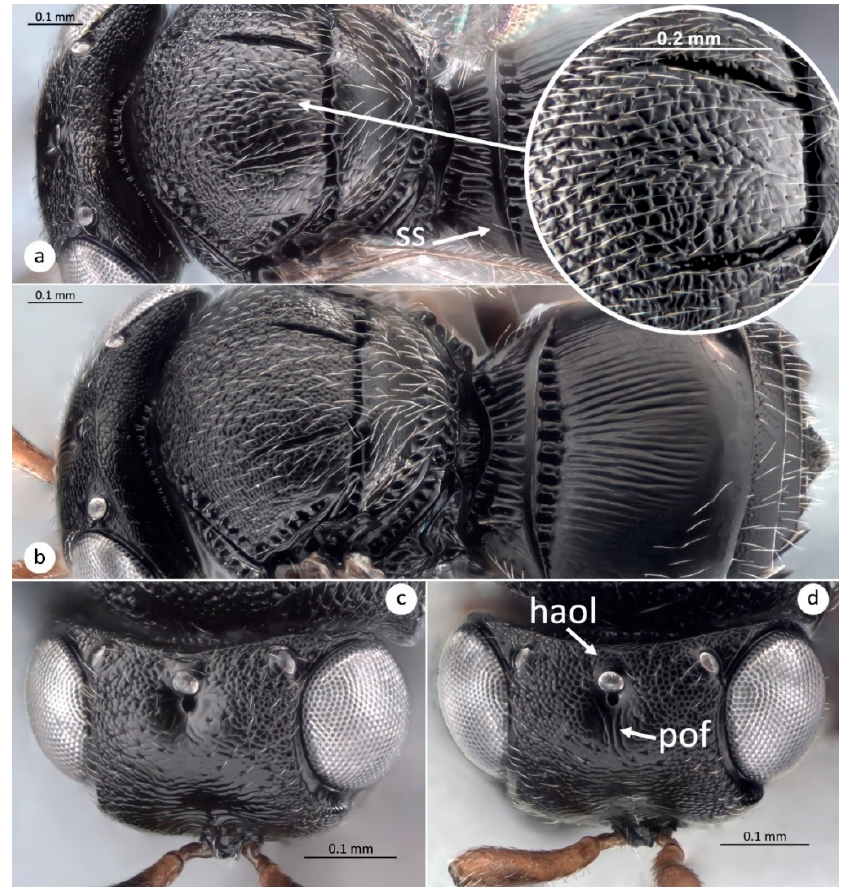
Figure 1. Trissolcus kozlovi and T. japonicus . ( a )—female of T. kozlovi , head, mesosoma (in detail median area of the mesoscutum), metasoma ( ss = sublateral seta), dorsal view; ( b )—female of T. japonicus , head, mesosoma, metasoma, dorsal view; ( c )—female of T. kozlovi , head, anterodorsal view; ( d )—female of T. japonicus , head, anterodorsal view ( haol = line between the dorsal margin of hyperoccipital carina and posterior margin of anterior ocellus; pof = preocellar furrow). 3.2. Mating Tests and Reproductive Isolation between T. kozlovi and T. japonicus × Females used for intraspecific combinations T. kozlovi ( , test 3) and T. japonicus × , test 4) successfully produced female offspring (Figure 2) with female to male ratios ♀ ♂ of 5.7:1 and of 4.9:1,